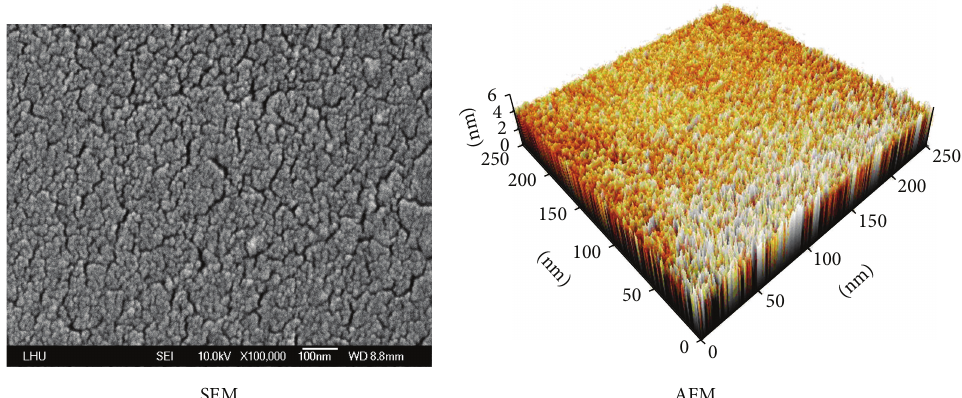
Figure 5: The SEM and AFM images for sample number 2.